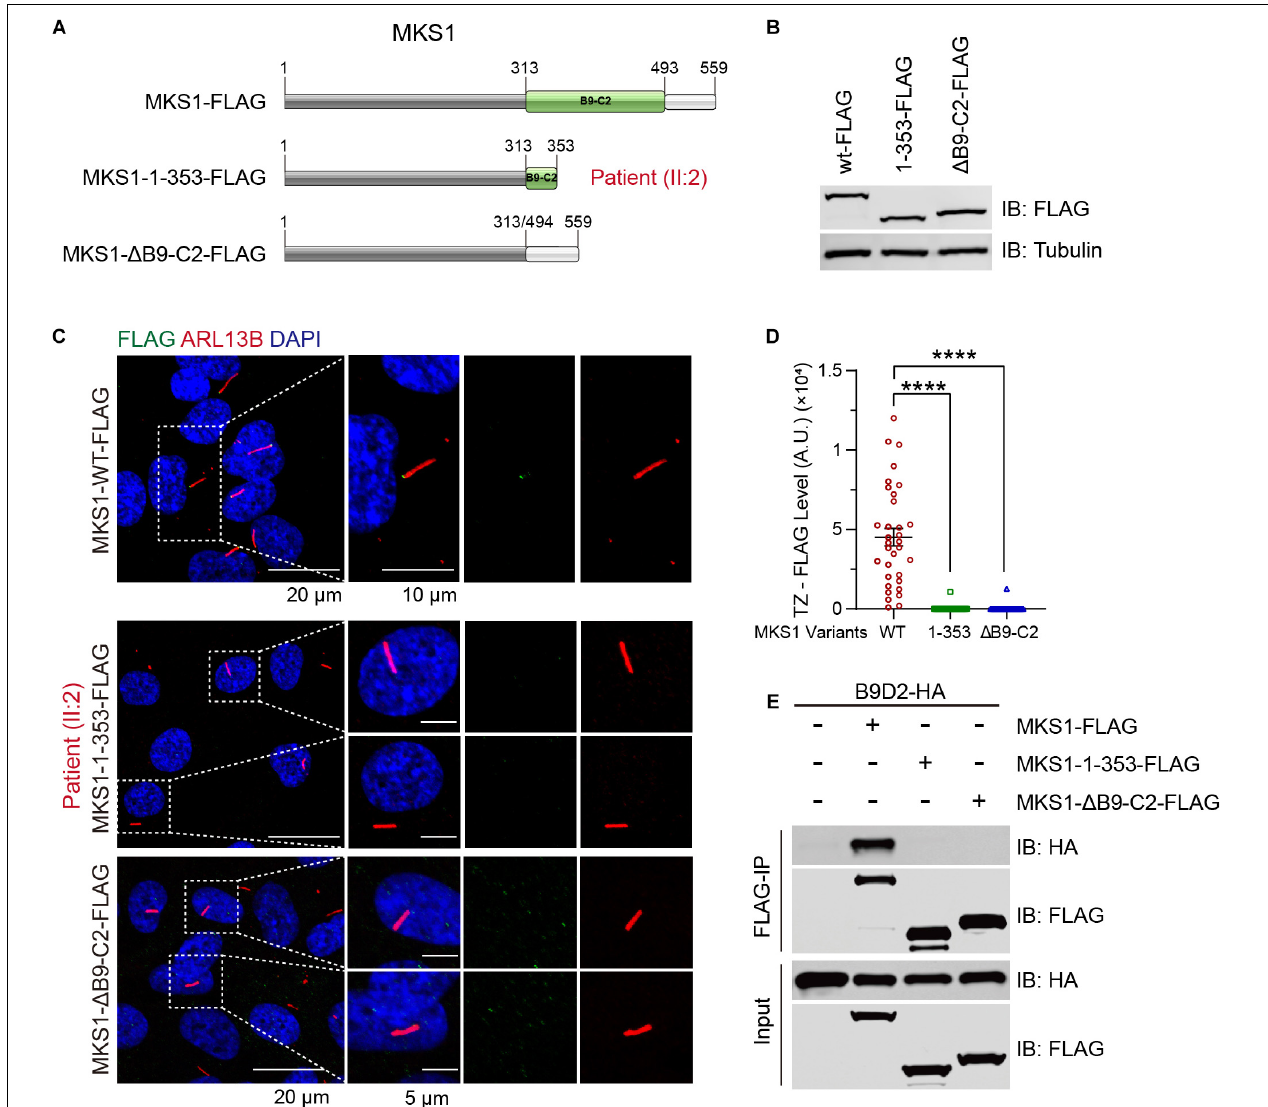
FIGURE 3 | MKS1 mutant fails to localize at the transition zone and lose the interaction with B9D2. (A) Schematic diagram of the domain structure of MKS1 variants (wild type, MKS1 1-353, and MKS1 lacking B9 domain). (B) Immunoblot analysis of RPE1 cell lines stably expressed FLAG-tagged MKS1 variants shown in (A) . (C) Immunostaining of RPE1 cells expressing FLAG-tagged MKS1 variants. MKS1 variants (FLAG, green), cilia (ARL13B, red), and nuclei (DAPI, blue). (D) Quantification of MKS1 variant levels at the transition zone. Each dot represents the signal of one cell. Data from three independent experiments was used for the quantification. Error bars represent mean ± SD. Statistical significance was determined by an unpaired Student’s t -test (**** p < 0.0001). (E) Immunoprecipitation of FLAG-tagged MKS1 variants with